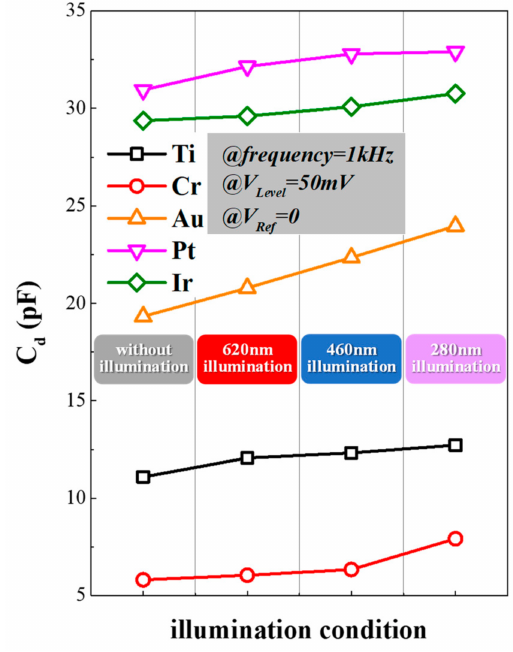
Figure 6. The change of C d versus the wavelength (V Ref = 0 and V Level = 50 mV at 1 kHz) of microelectrodes caused by different surface